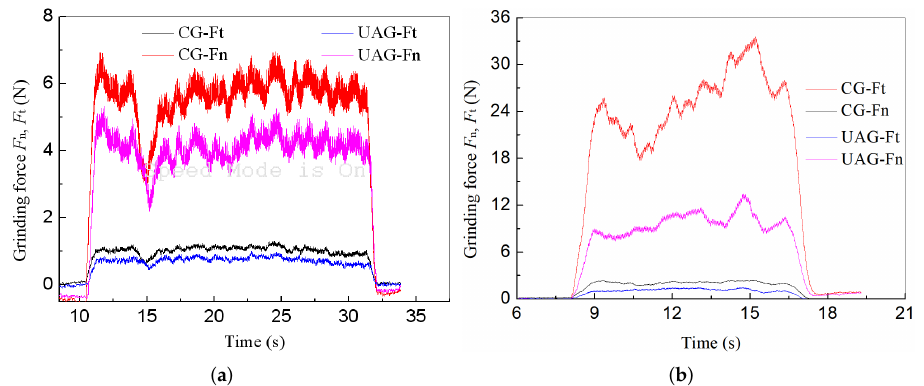
Figure 5. ( a ) Typical grinding force signal for side grinding. The process parameters used in image collection are v s = 1.26 m/s, a p = 30 µ m, v w = 100 mm/min. ( b ) Typical grinding force signal for end grinding. The process parameters used in image collection are v s = 1.26 m/s, a p = 10 µ m, v w = 100